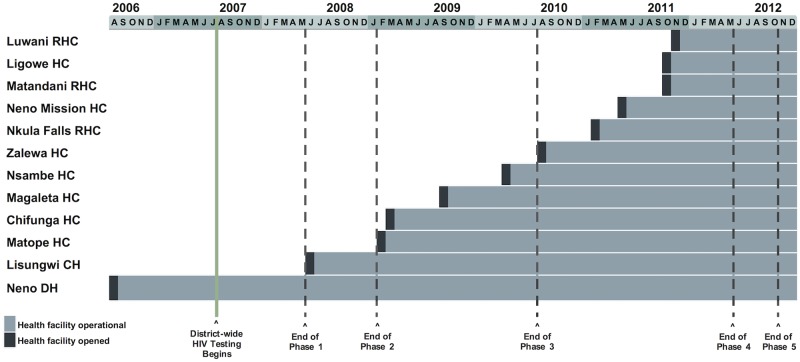
ART decentralization timeline.The timeline displays HIV care in Neno District from August 1, 2006, when public care first became available, through December 31, 2012. (DH = district hospital, CH = community hospital, HC = health center, RHC = rural health center).